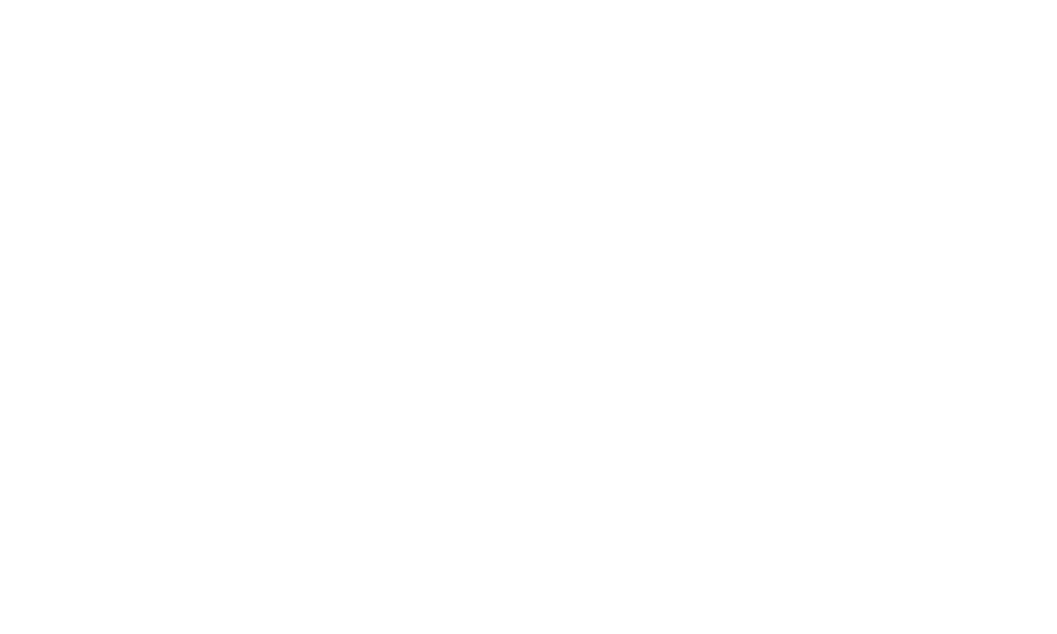
Frontiers in Pharmacology |